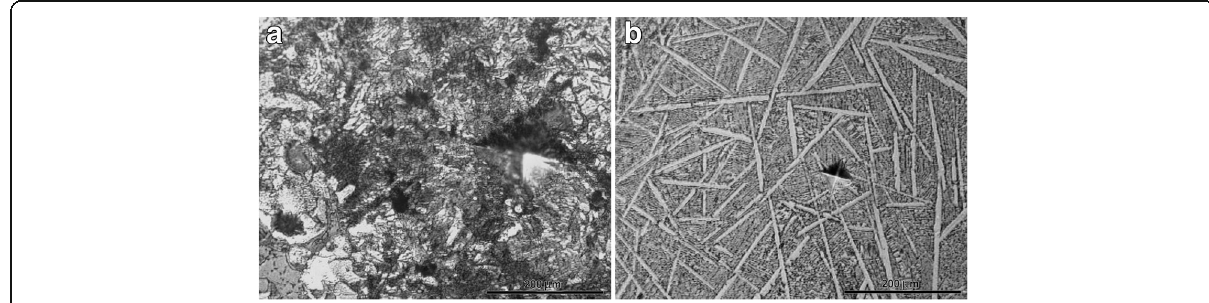
Fig. 1 Microstructure in different zones of the slag material of ASTM 514 grade S. a Austenitic zone. b Ferrite +